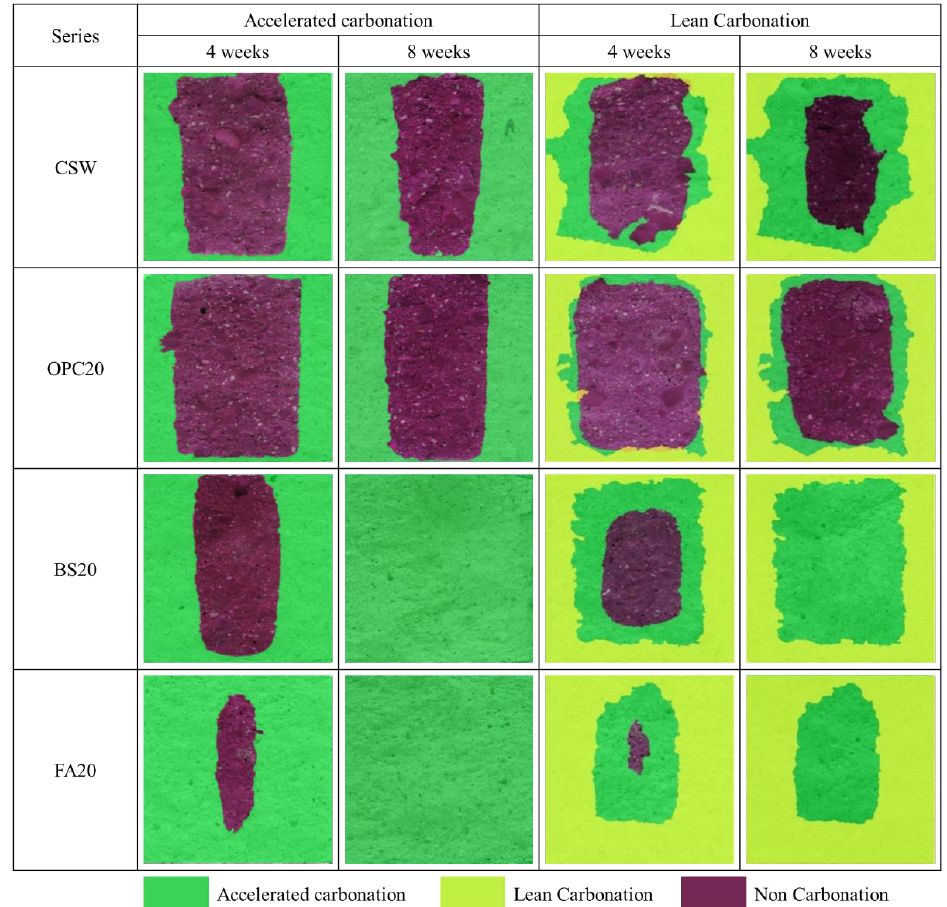
Figure 16. Carbonation depth measurement results before and after Lean Carbonation.